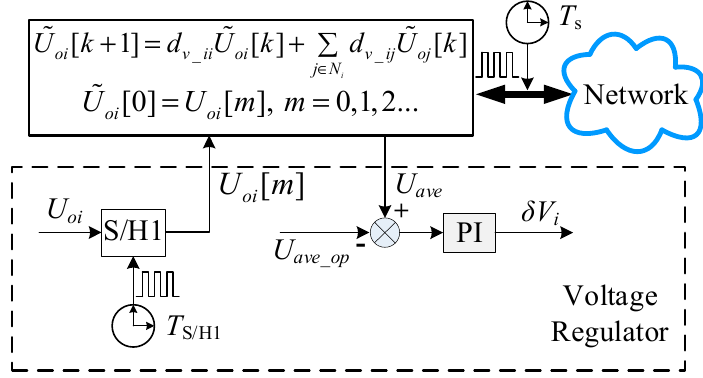
Figure 2. Voltage regulation in secondary control level.